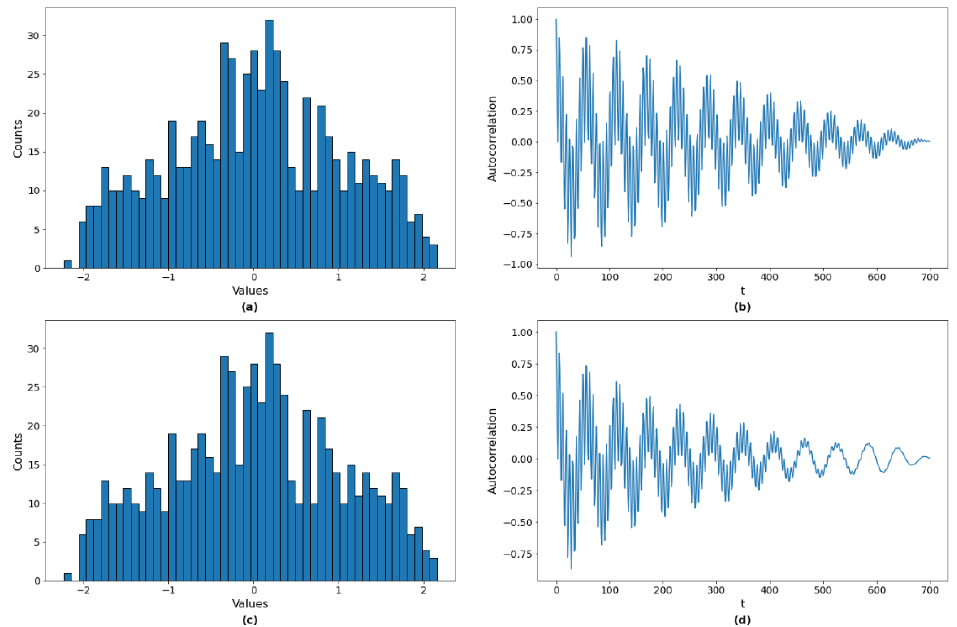
Figure 13. Distribution ( a ) and autocorrelation function ( b ) of the simulated data and the distribution ( c ) and autocorrelation function ( d ) of the IAAFT surrogate data.